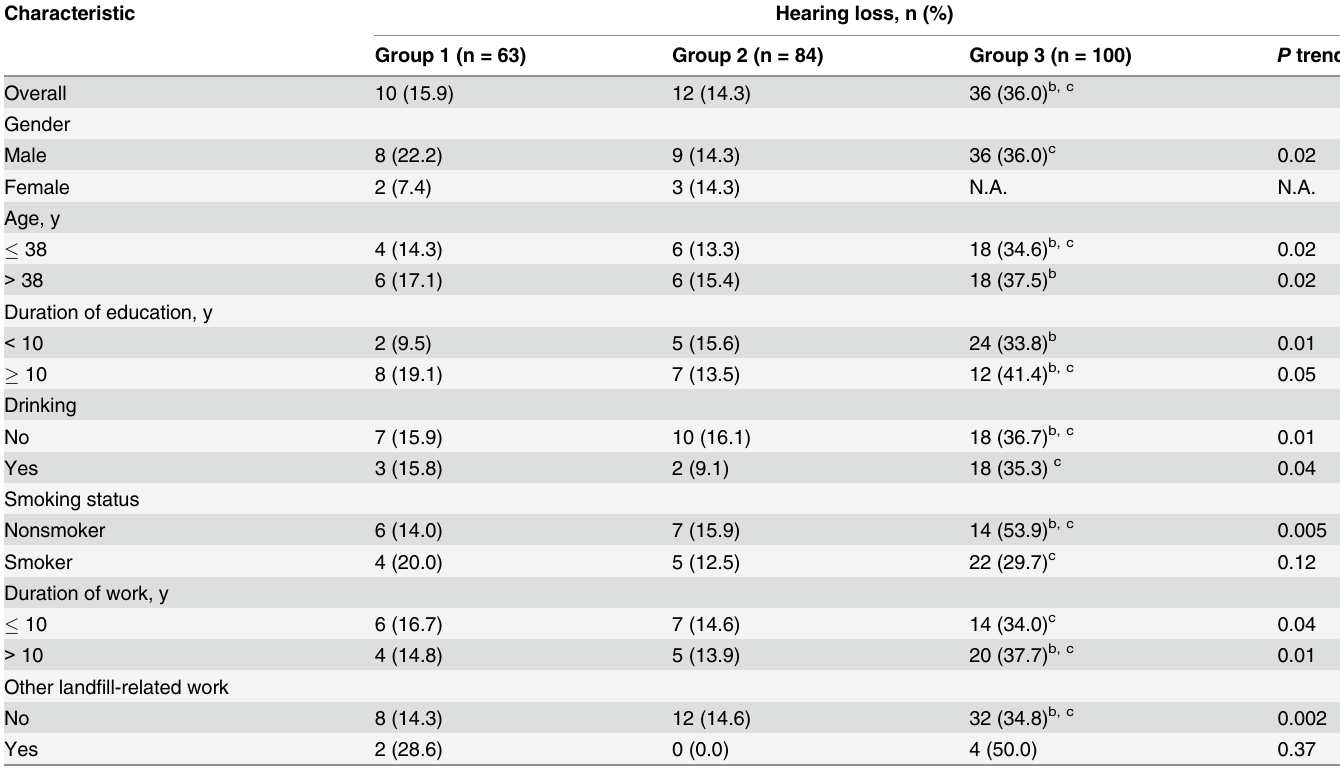
Table 5. Hearing loss based on OSHA standard by selected characteristics in different groups of MSWL